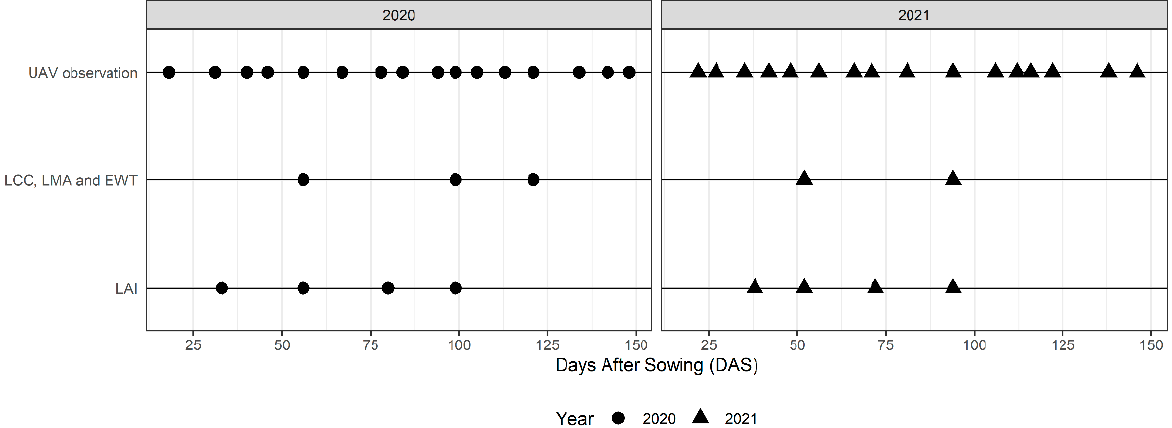
Figure 2. Seasonal calendar of UAV observations and crop measurements (LAI, LCC, LMA, and EWT) during the two years (2020 and 2021).